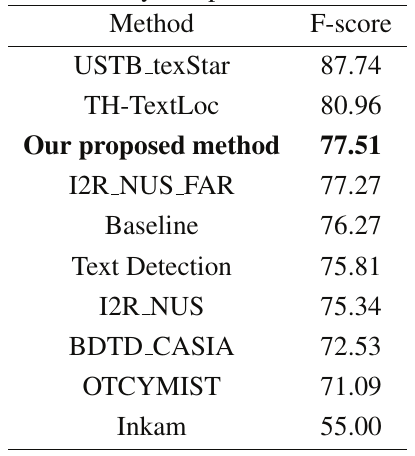
Table 3: Accuracy comparison on